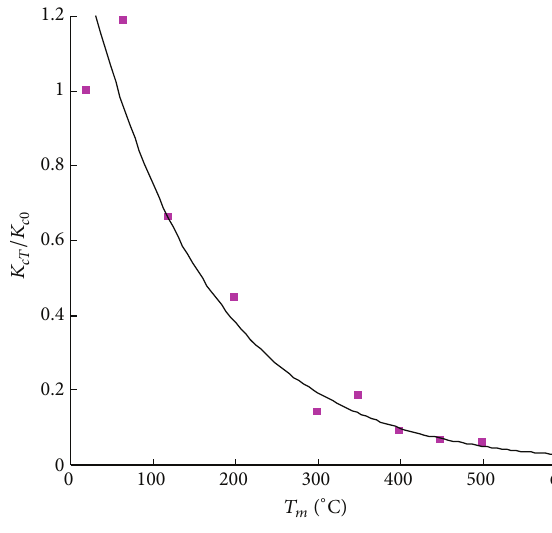
Figure 11: Stiffness 𝐾 𝑐 with 𝑇 𝑚